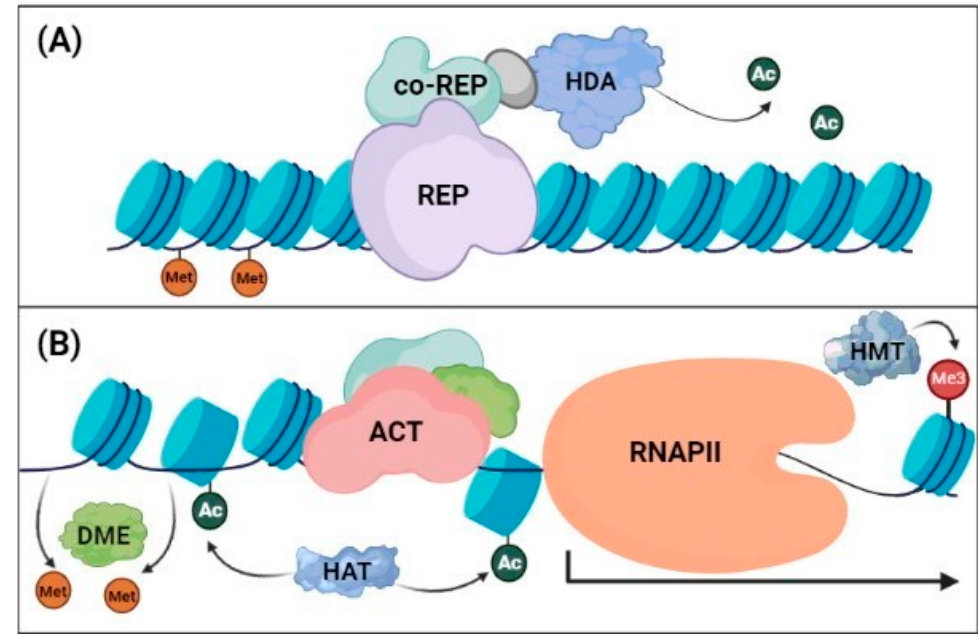
Figure 2. Hypothetical model of chromatin remodeling for the regulation of gene transcription. ( A ) Repression of gene transcription. Under normal conditions, promoter DNA is methylated, and repressors (REPs) or REP-corepressor (co-REP) complexes recruit histone deacetylases (HDAs) to compact the local chromatin region, leading to gene suppression. ( B ) Activation of gene transcription. For gene transcription, promoter DNA is demethylated by DNA glycosylase (DME). Repressors are released from the promoter, and activators (ACTs) or activator complexes bind to the open promoter region, which facilitates RNA polymerase II (RNAPII) access to initiate gene transcription. Histones are acetylated by histone acetyltransferases (HATs) to weaken DNA–histone interactions or are methylated by histone methyltransferases (HMTs).